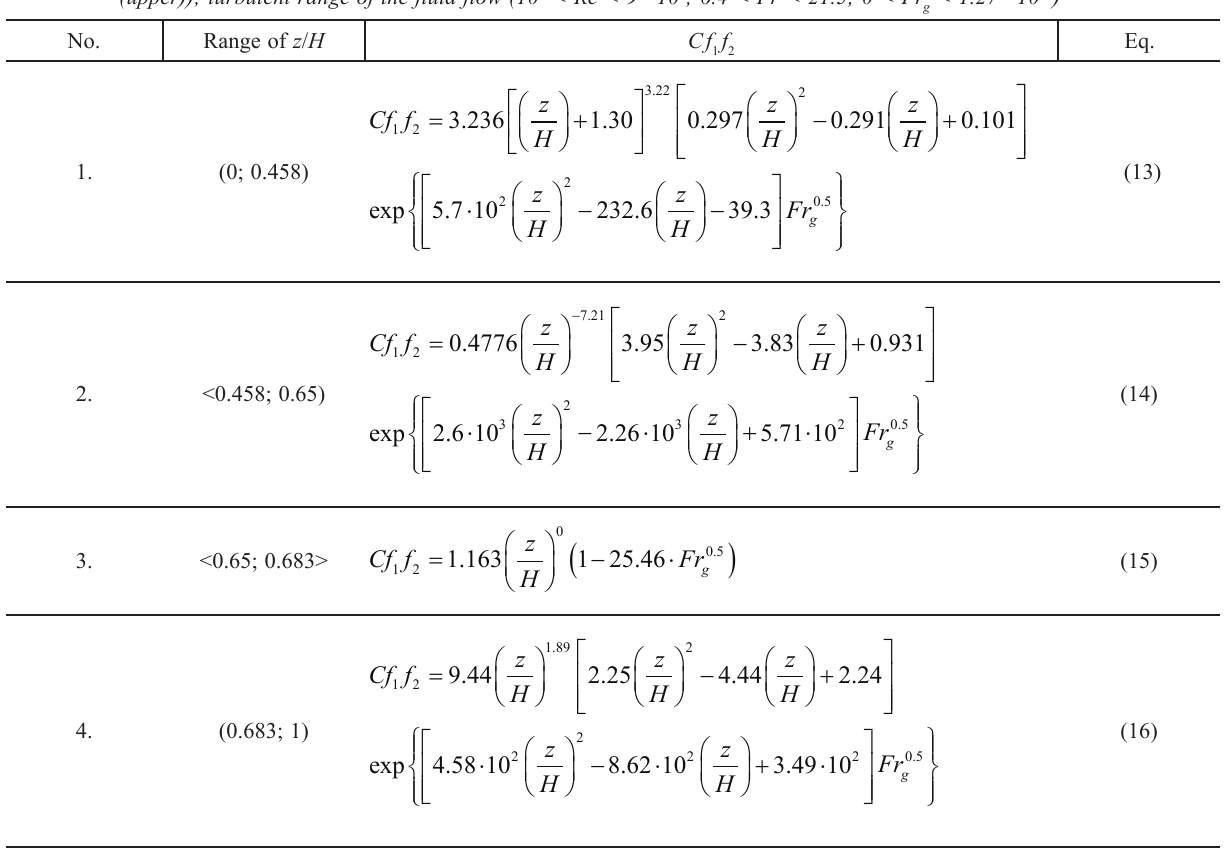
Table 1 – Functions Cf f in Eq. (12) for gas­liquid systems agitated using two impellers on a common shaft (A 315 (lower) – RT 1 2 (upper)); turbulent range of the fluid flow (10 4 < Re < 9 · 10 4 ; 6.4 < Pr < 21.5; 0 < Fr No. Range of z / H C f